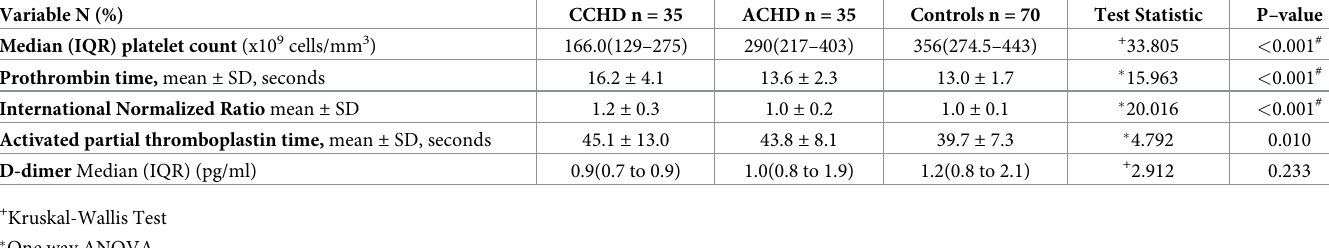
Table 3. Comparison of coagulation profile between CHD subjects and